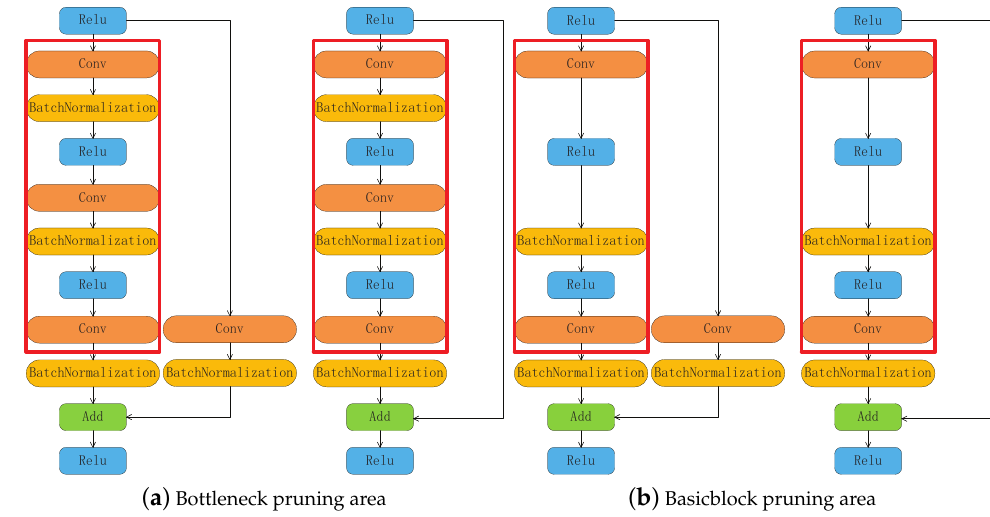
Figure 3. HRnet basic network structure pruning